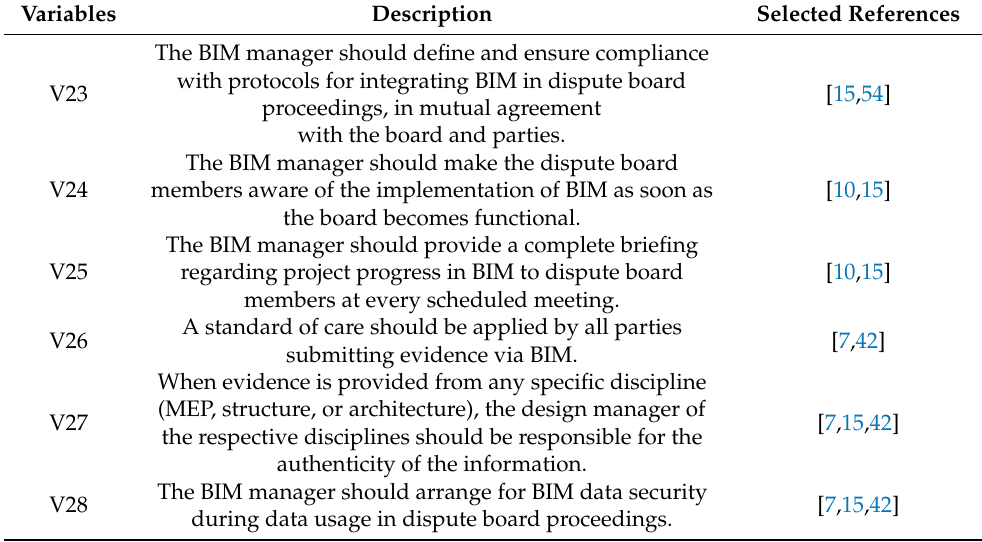
Table 3. Potential legal aspects/contract provisions for roles and obligations.